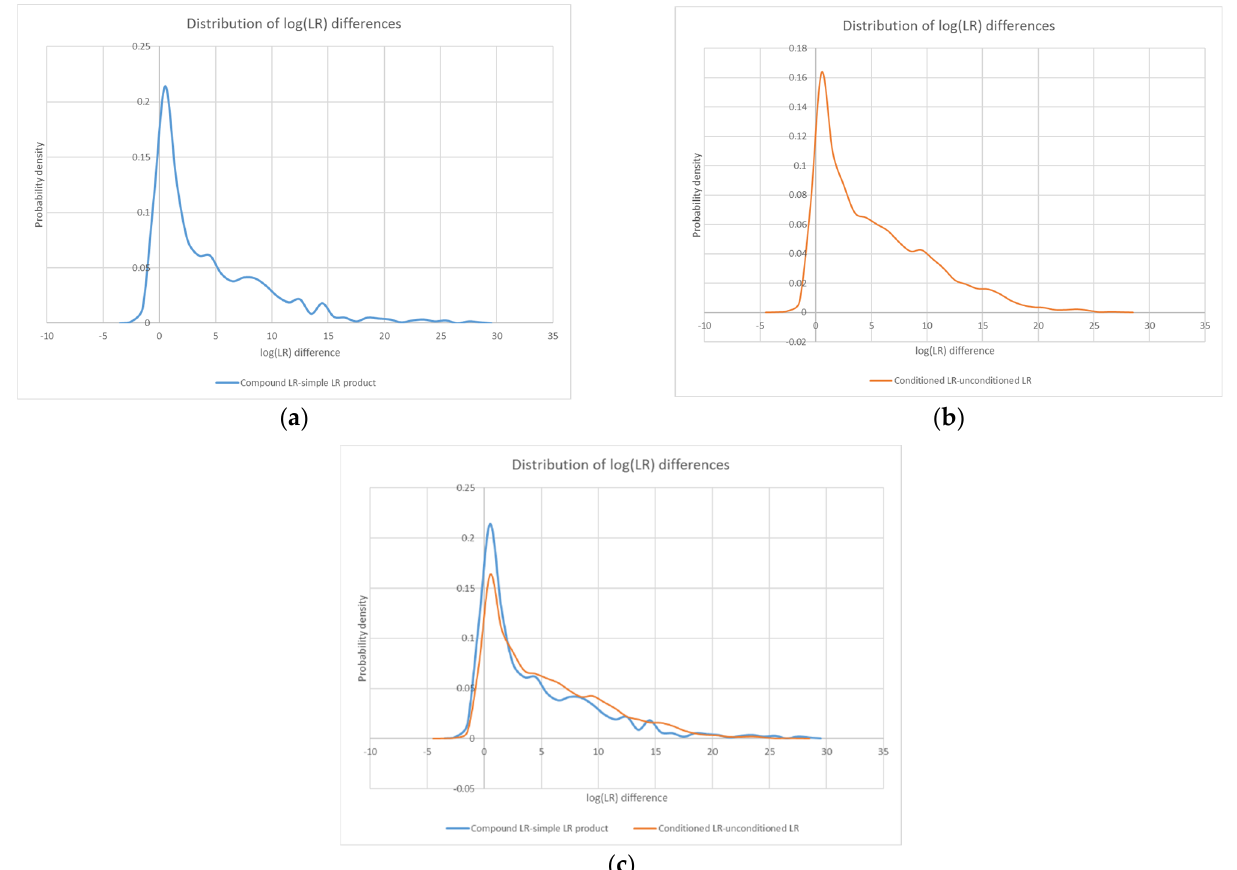
Figure 7. Probability density distributions for the log difference between all compound LRs in the study and their corresponding simple LR products ( a ), as well as all conditioned LRs in the study and their unconditioned counterparts ( b ). An overlay of the two distributions ( c ) highlights their similarity.